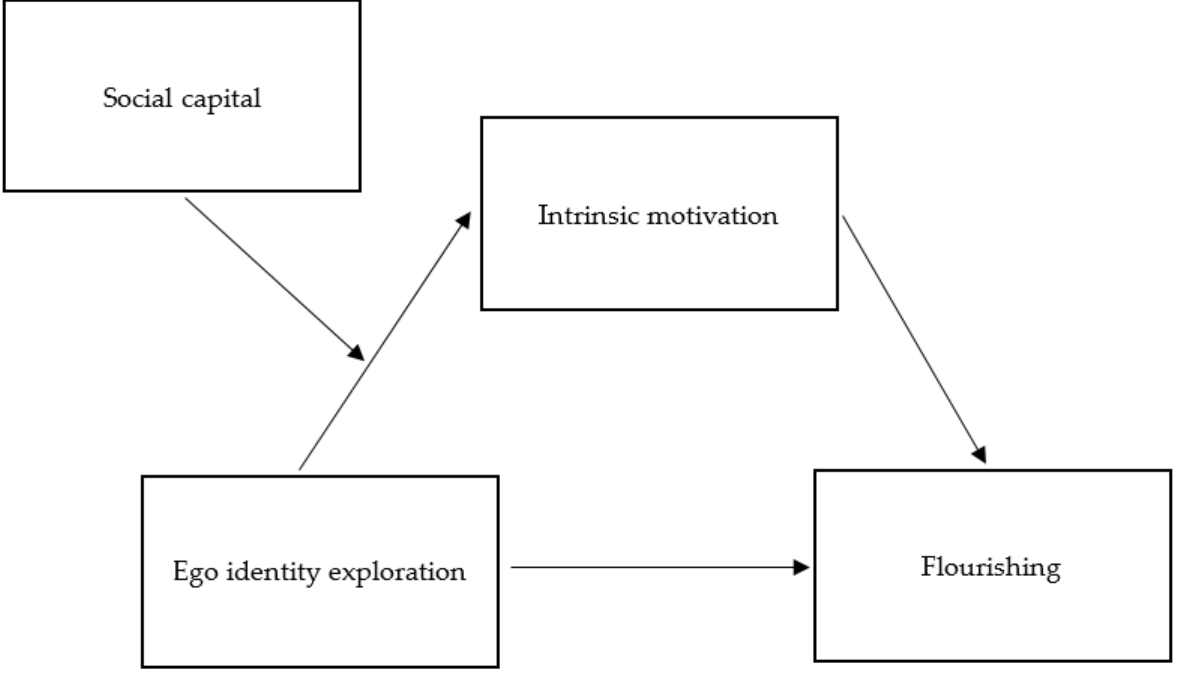
Figure 1. A hypothesized moderated mediation model.